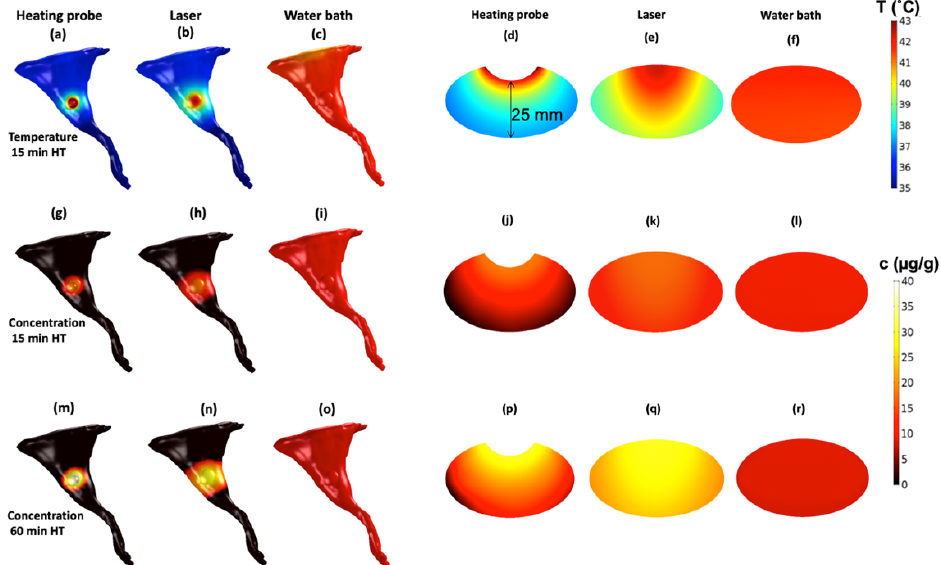
Figure 16. Effect of hyperthermia device on drug delivery. A prior study presented 3-D computer model results on three hyperthermia (HT) devices, assuming a subcutaneous tumor on a mouse hindlimb. The temperature profile after 15 min HT (=steady state profile) is shown for a heating probe, an infrared laser, and water bath heating on the hindlimb surface ( a – c ), and in a tumor cross section ( d – f ). The resulting drug concentration is shown after 15 min HT for the three devices, again on the limb surface ( g – i ), and in a tumor cross section ( j – l ). The resulting drug concentration is shown after 60 min HT on the limb surface ( m – o ), and in a tumor cross section ( p – r ). Figures reproduced from [162] (published under CC BY 4.0